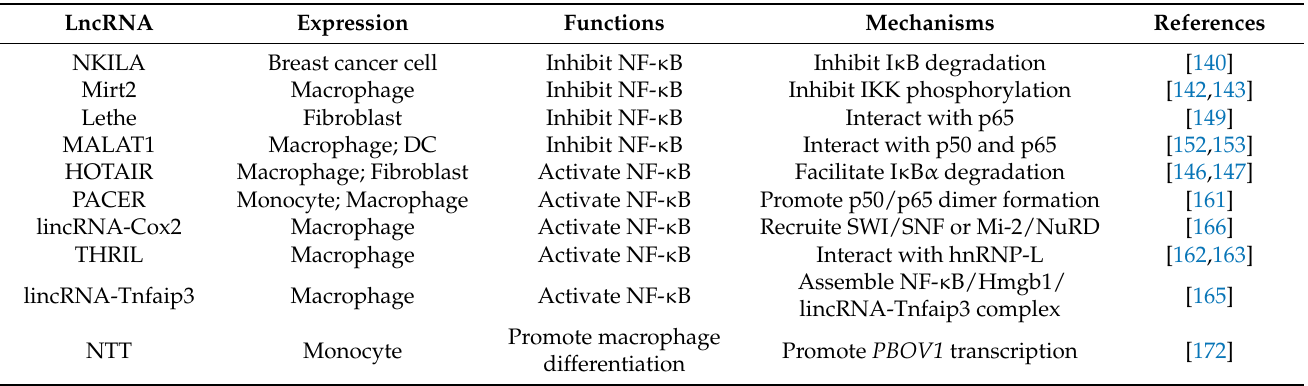
Table 2. The lncRNAs involved in the host